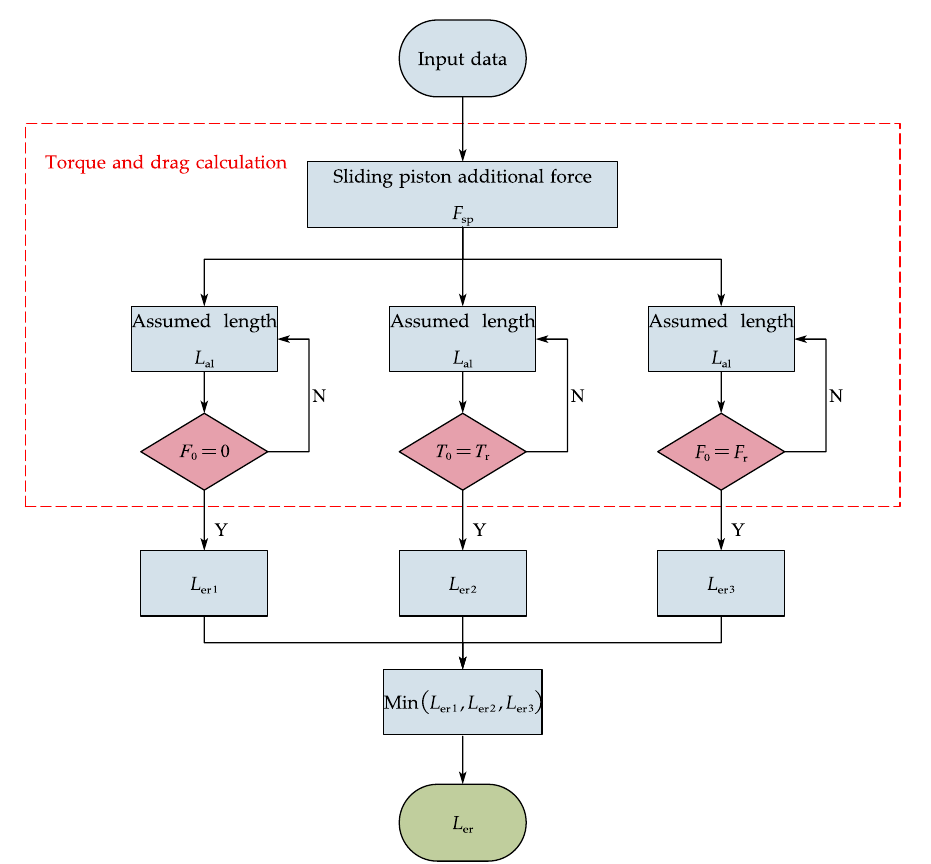
Figure 5. Calculation procedure of the mechanical extended-reach limit of the dual-channel drillpipe drilling.